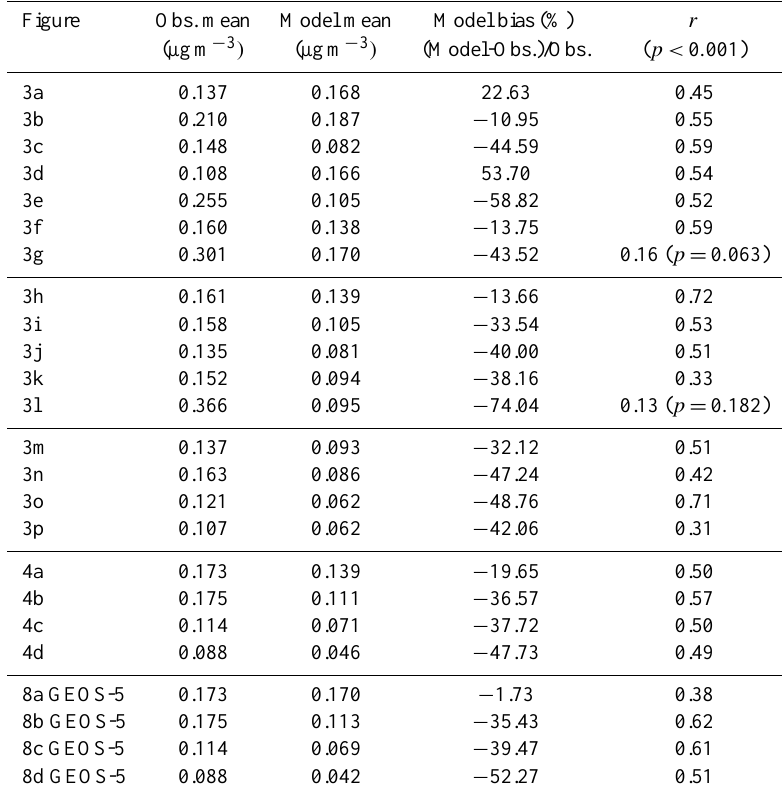
Table 1. GEOS-Chem simulated and IMPROVE observed mean surface BC concentrations, model biases, and correlation coefficients between model results and observations (Figs. 3, 4 and 8). Figure Obs. mean Model mean Model bias (%) r (µgm − 3 ) (µgm − 3 ) (Model-Obs.)/Obs. ( p < 0 .